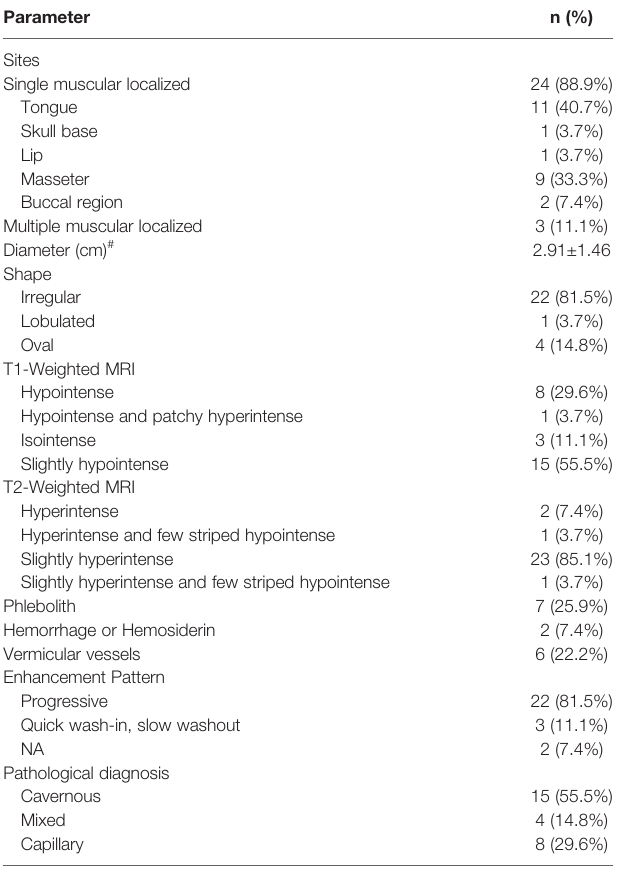
TABLE 3 | Preoperative MRI fi ndings of 27 patients with intramuscular hemangiomas. Parameter n (%) Sites Single muscular